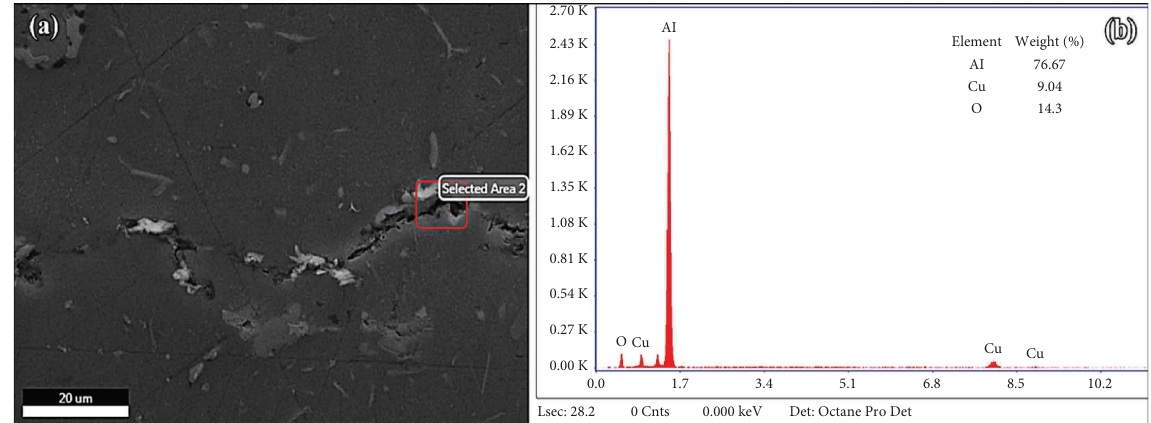
Figure 13: (a) EDS and (b) spectral analyses for the bonded section at 450 ° C.